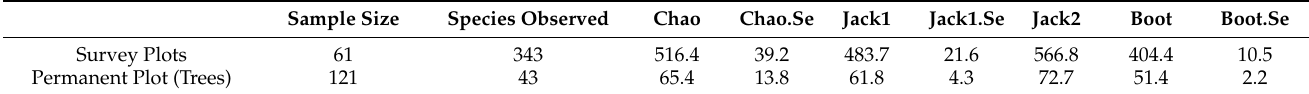
Figure 1. Species accumulation curves (SACs): ( a ) SAC for entirety of study, with all land uses combined. Dotted line is the estimated number of species using a Chao estimator, with one standard error. ( b ) SAC for single 0.5 hectare permanent plot. Dotted line is the estimated number of species using a Chao estimator, with one standard error. ( c ) SAC for entirety of study, itemized by land- use/habitat type. See Section 2.2.1 for explanation of land-use/habitat abbreviations. Table 1. Estimates of adult tree species diversity in survey area and permanent plot, Using Chao, First- and Second-order jackknife, and bootstrap methods. Uncertainties are given as standard error (“.Se”). Sample